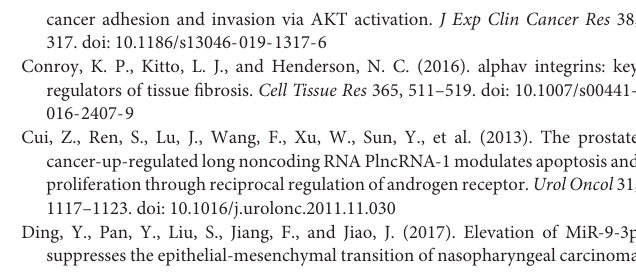
FIGURE S1 | SNHG17 promotes CD51 and suppresses miR-144 expression in CRPC in vivo . (A) The effects of SNHG17 on the mRNA levels of CD51 in vivo , as detected by RT-QPCR. (B) The effects of SNHG17 on the protein levels of CD51 in vivo , as detected by immunofluorescence. (C) The effects of SNHG17 on the expression of miR-144 in vivo , as detected by RT-QPCR. Data are expressed as the mean ± SE. * P < 0.05, ns: not significant. The representative results of 3 independent experiments are